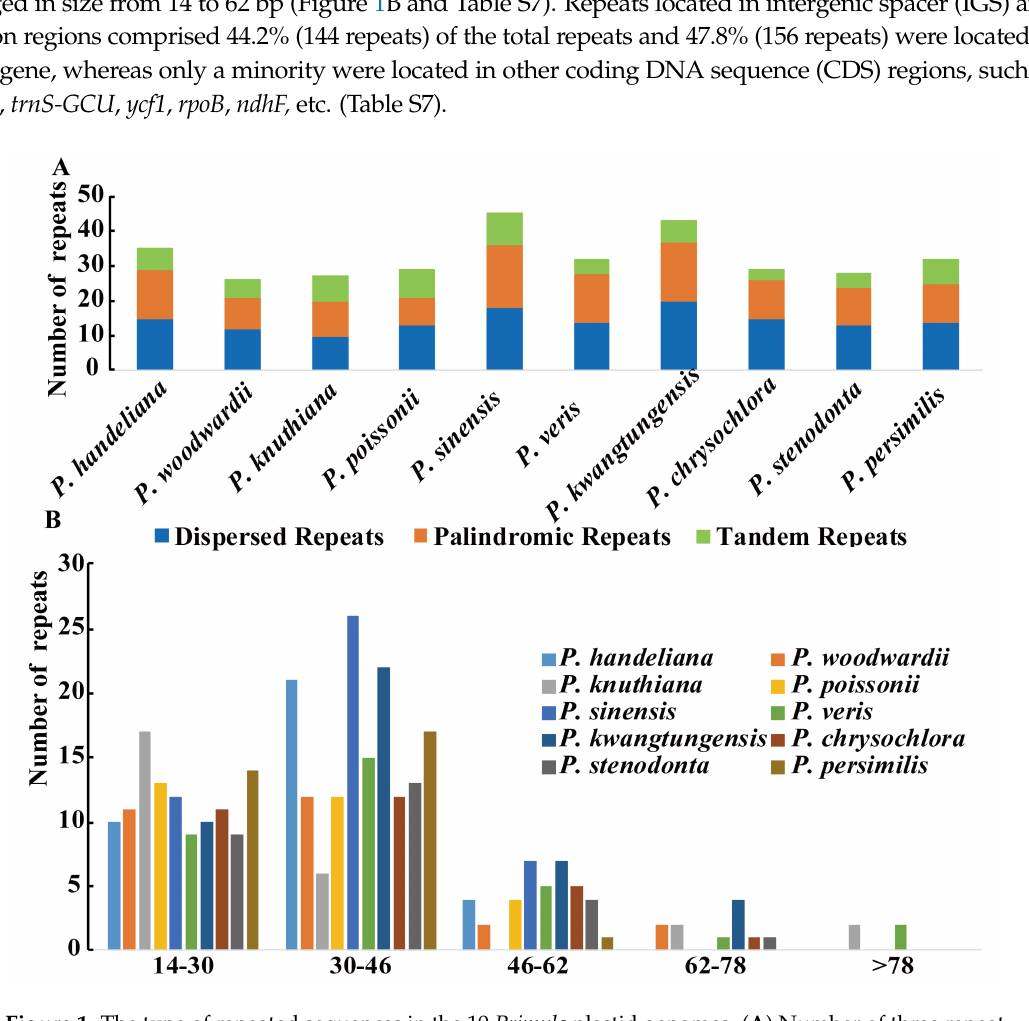
Figure 1. The type of repeated sequences in the 10 Primula plastid genomes. ( A ) Number of three repeat types; ( B ) number of repeat sequences by